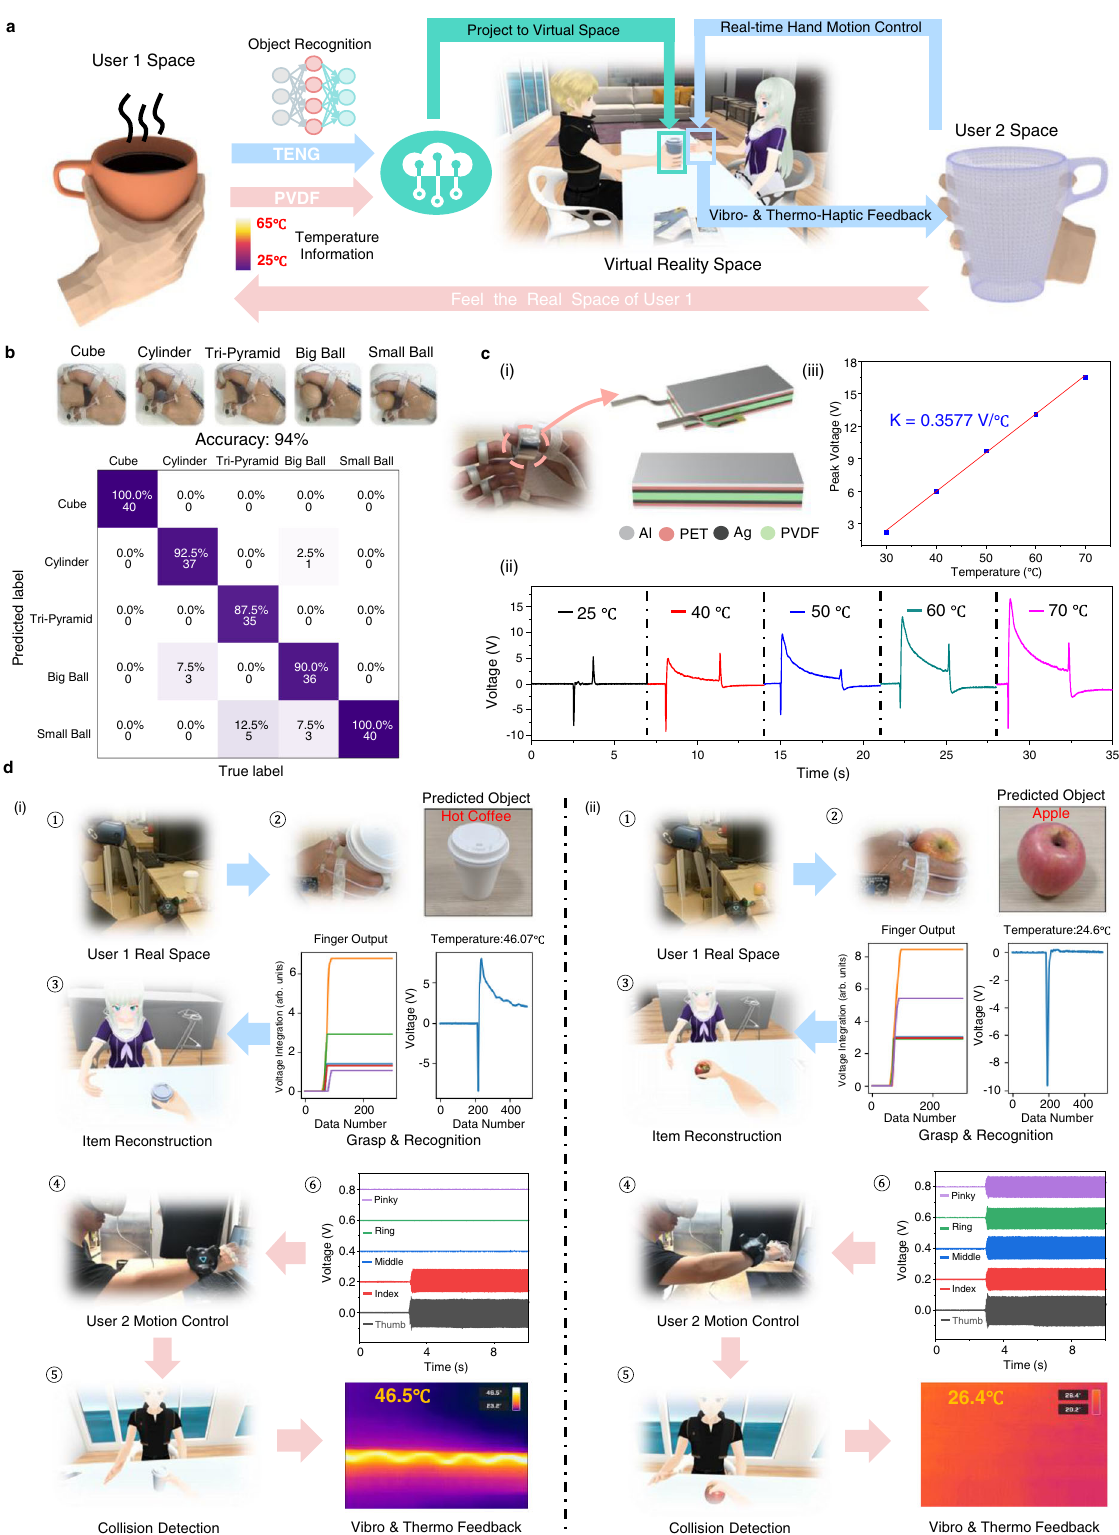
Fig. 5 | Multimodal sensing and feedback platform for metaverse. a System architecture of the ATH-Ring enabled interactive metaverse platform to provide users with cross-space sensation. b The illustration and the corresponding con- fusion map of 5 blocks with different sizes and shapes for verifying the grasped object recognition capability of the ATH-Ring enabled HMI. c The (i) detailed